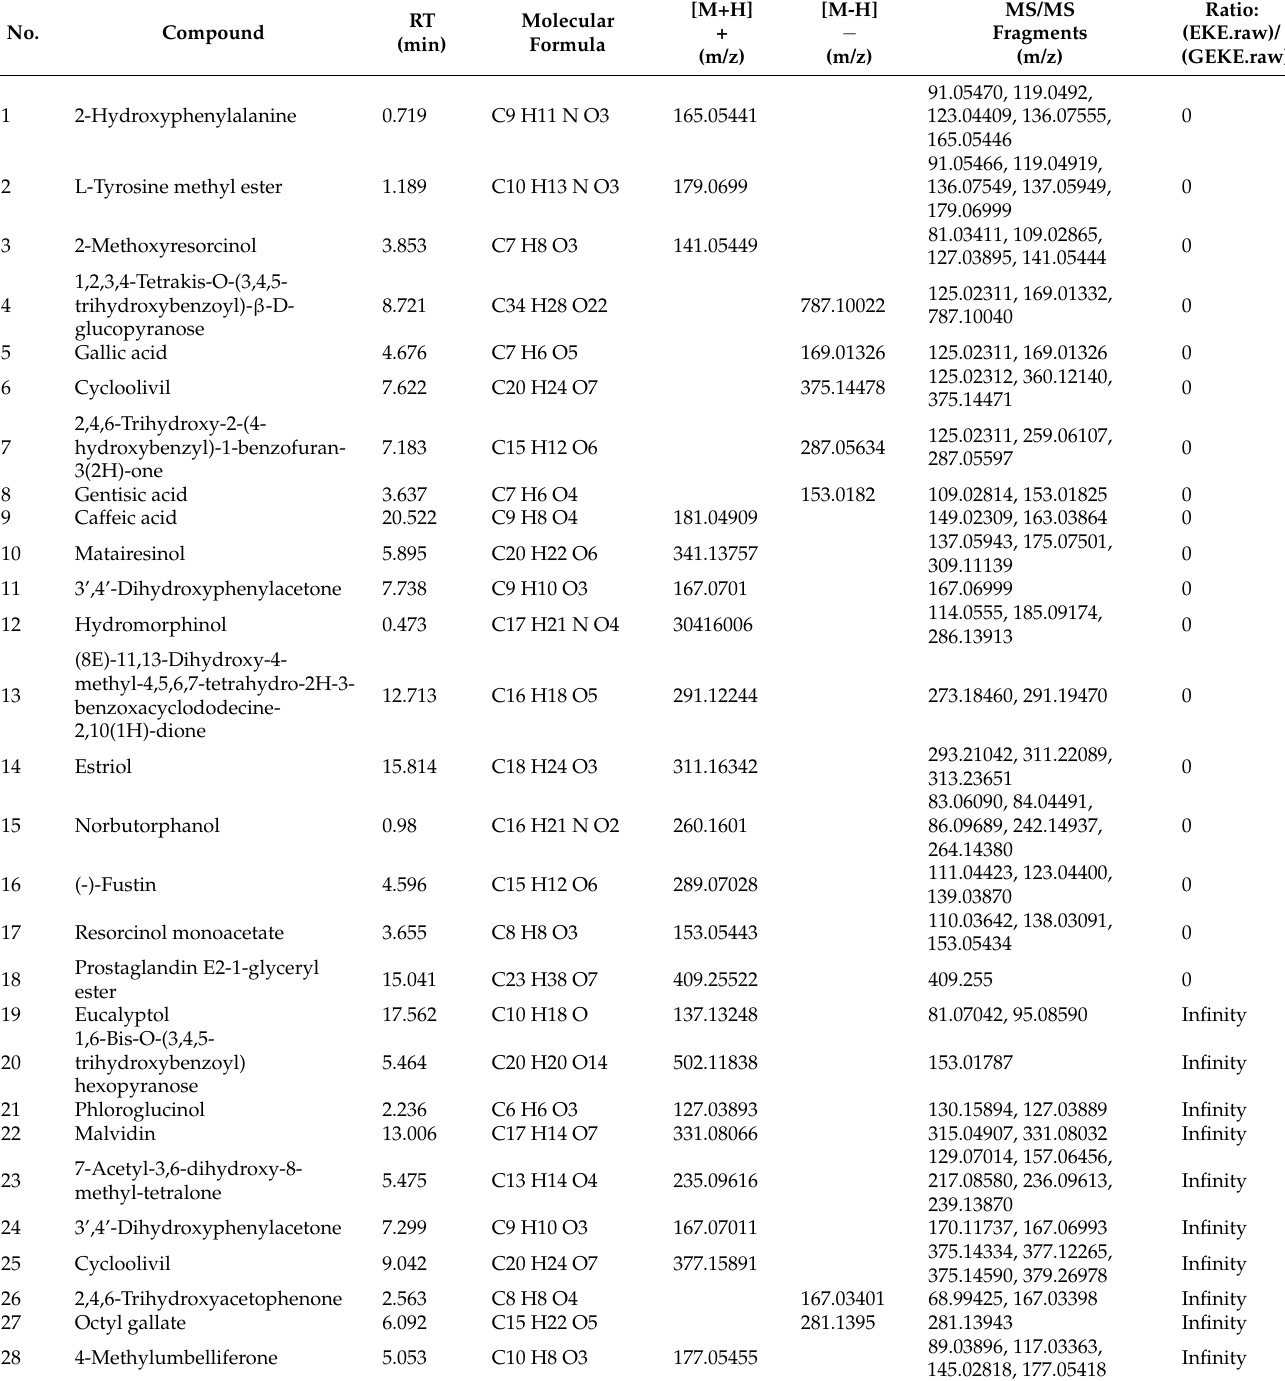
Table 3. Analysis of polyphenols and terpenoids in GEKE and EKE by